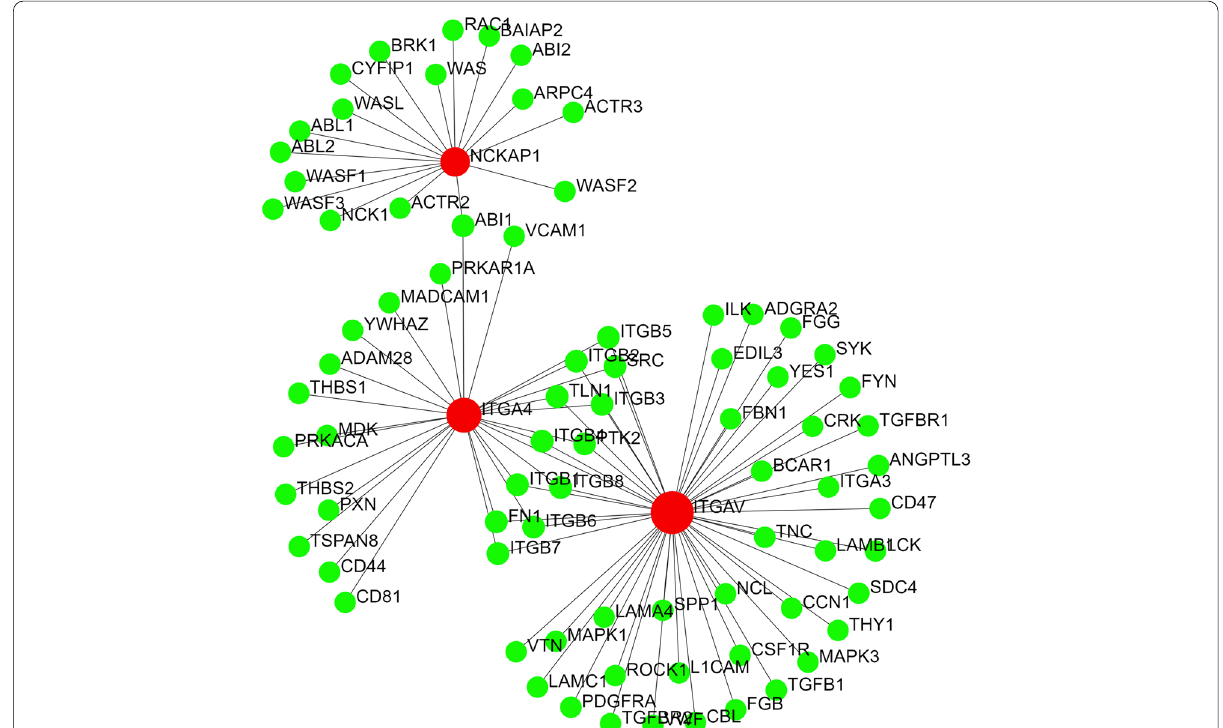
Fig. 2 PPI sub-network that includes ITGAV, ITGA4, and